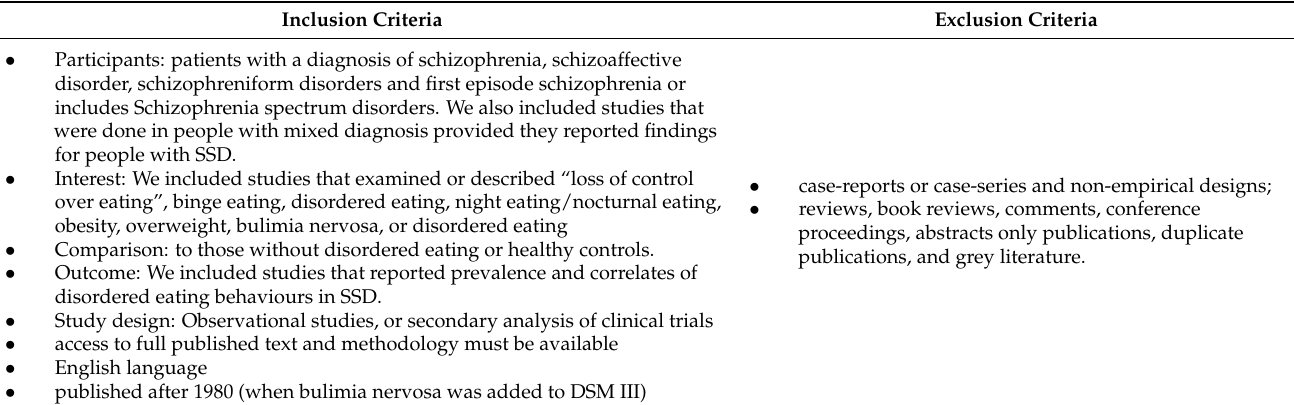
Table 2. Inclusion and exclusion